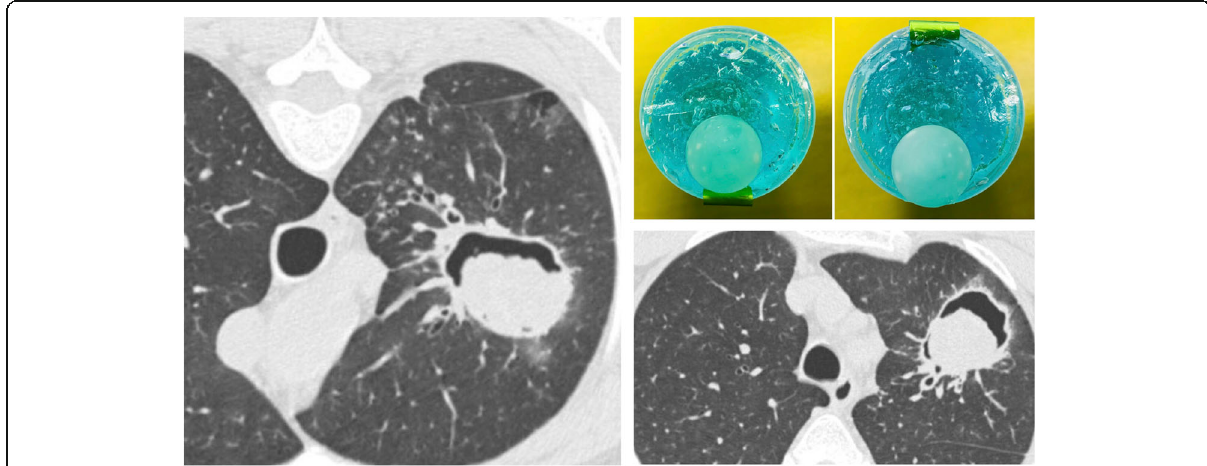
Fig. 22 Monod sign. Aspergilloma (asterisk) into a cavitated lesion located in a left upper lobe. The fungus mass moves according to the prone (left) and or supine (bottom left) patient position